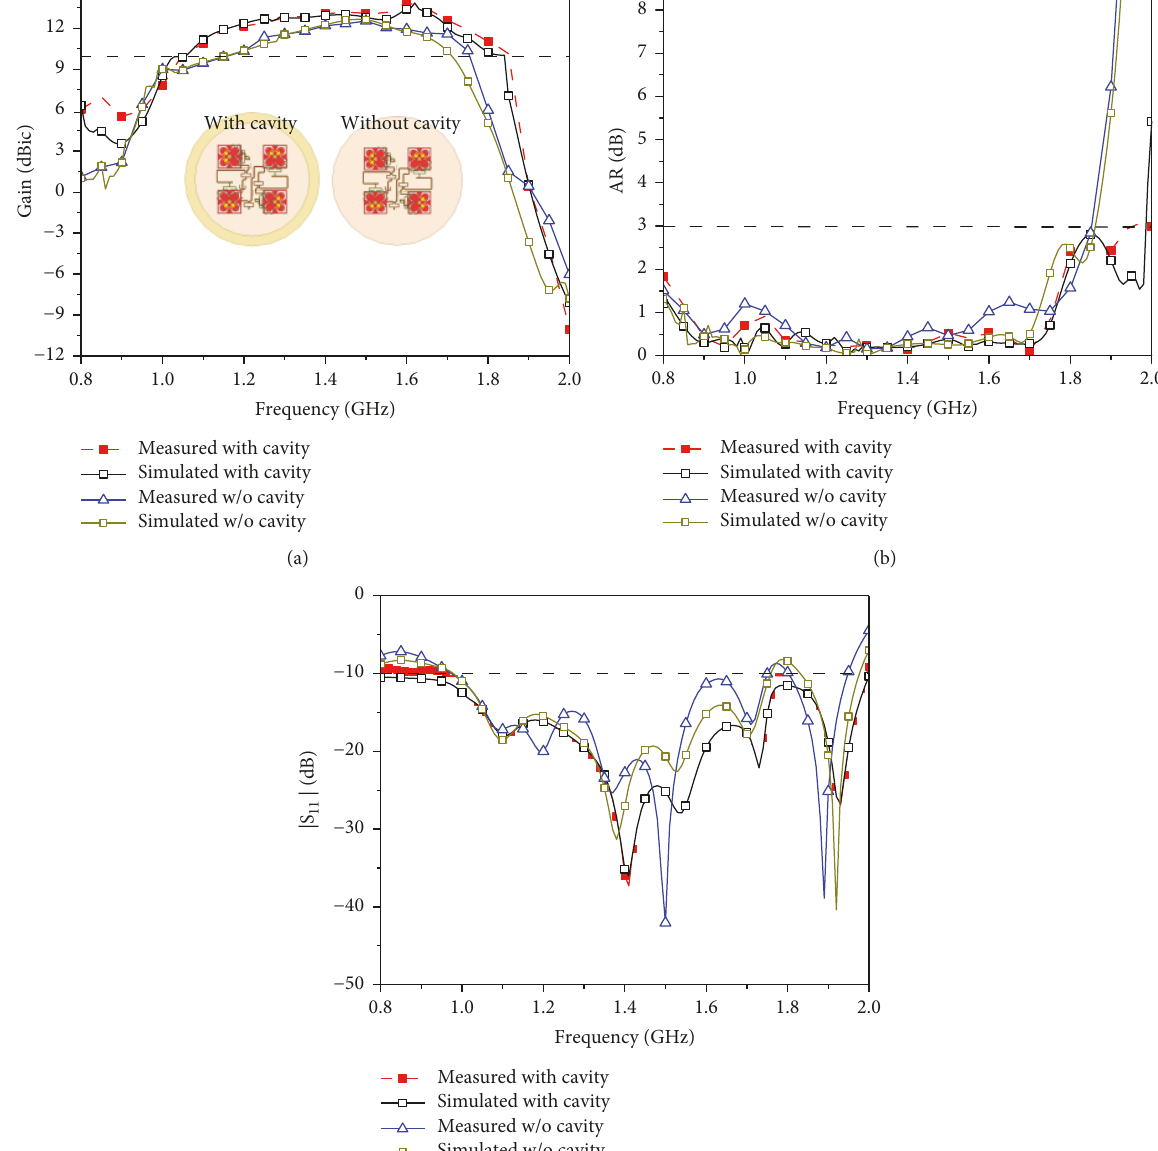
s . (a) Gains. (b) ARs. (c) S 11